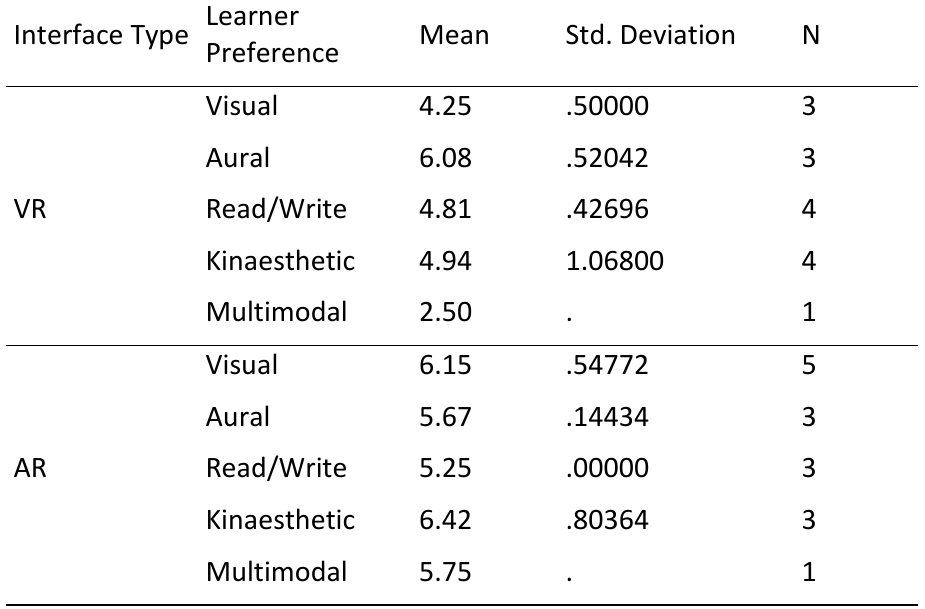
Table 4. Descriptive Statistics for Perceived Usefulness